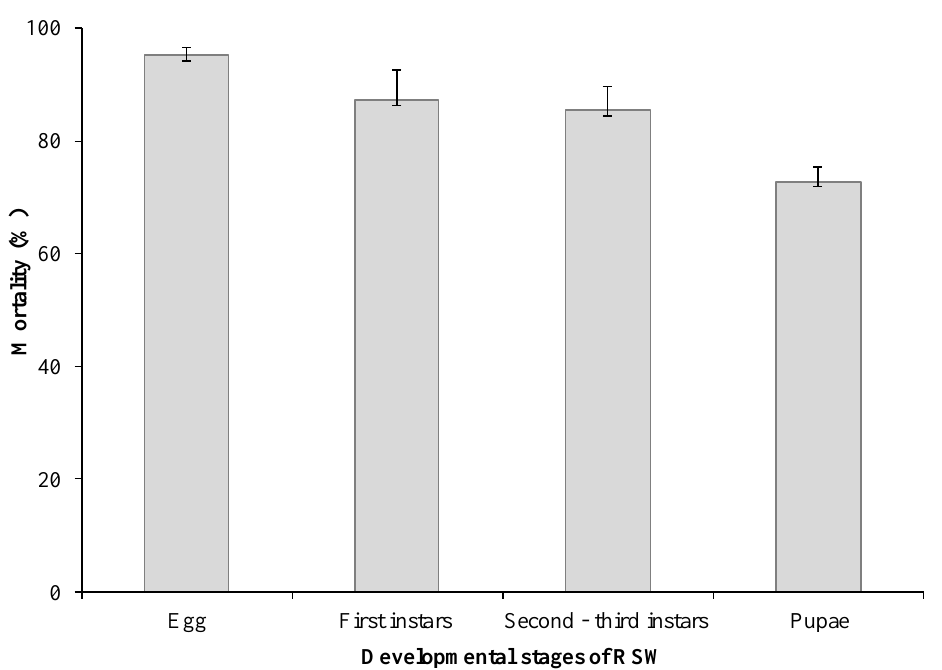
Figure 3. Pathogenecity of S. lanosoniveum tested at 1 × 10 8 conidia/mL against different develop- mental stages of RSW. Data are mean ± SEM of three tests.